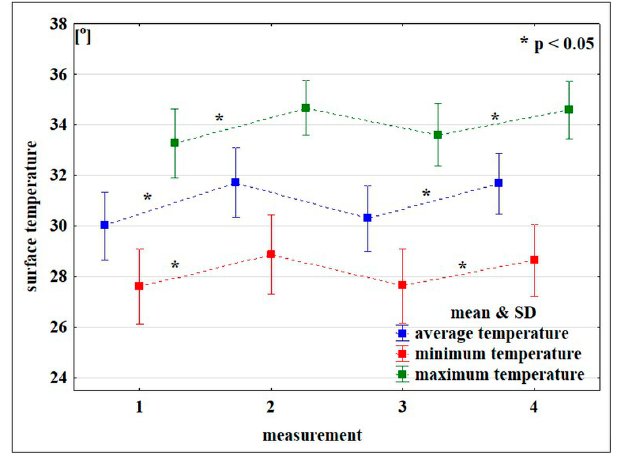
Figure 2. The surface temperature of the buttocks and thighs recorded in subsequent measurements during vibration therapy.